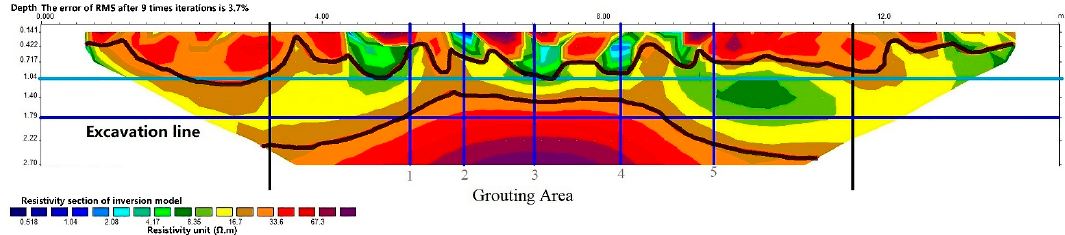
Figure 12. Photographs of HDRM in the axial direction.